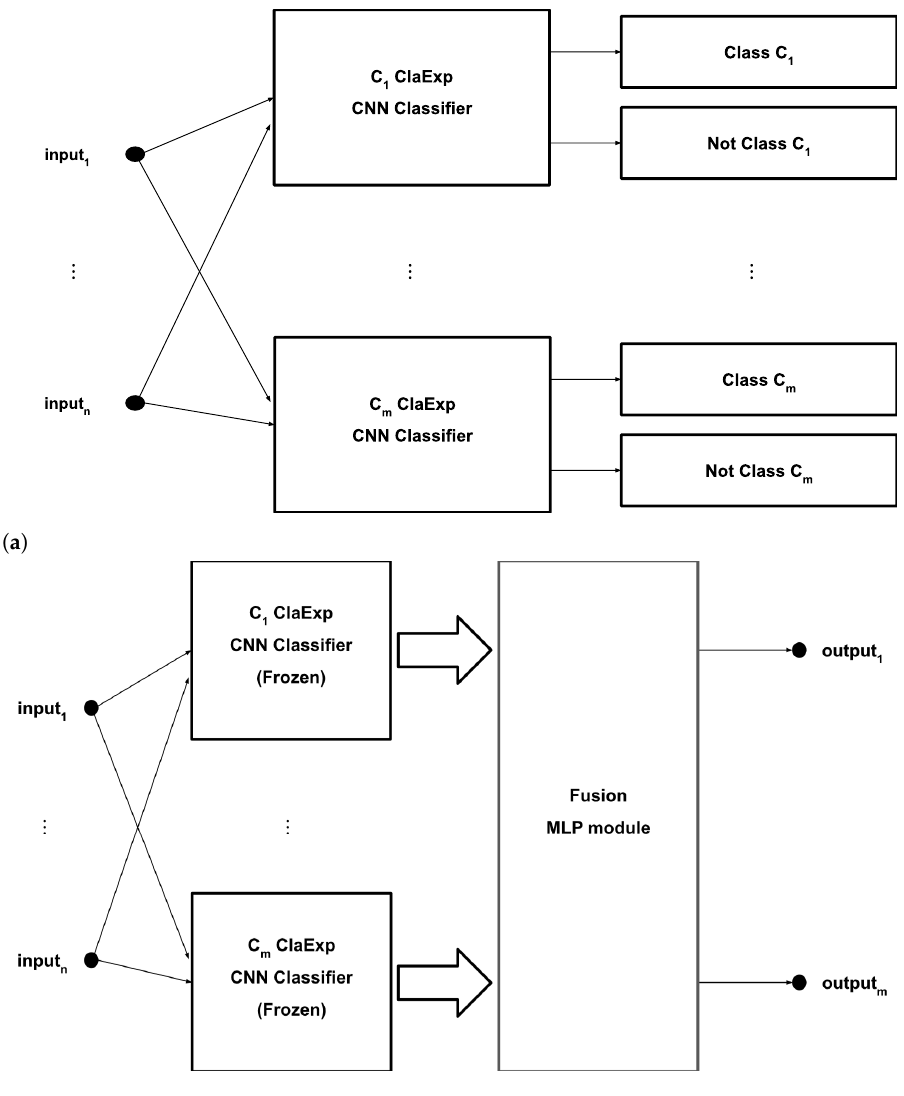
Figure 6. The classification system based on class-expert modules. In step one ( a ), the expert modules were trained. In step two ( b ), the trained expert models were frozen up to their classification layers, which were then all removed. In the sequence, a new classification layer was added to fuse the expert contributions obtained from the frozen models. The number of output nodes in this last layer equals the number of target classes. See